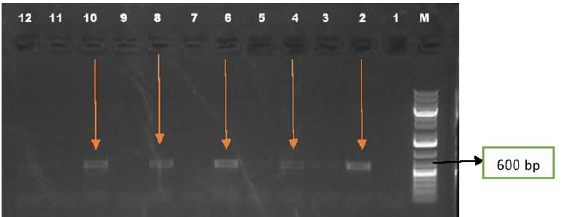
Fig. 6. Gel image of ndhF primer amplified Inula gDNA’s by